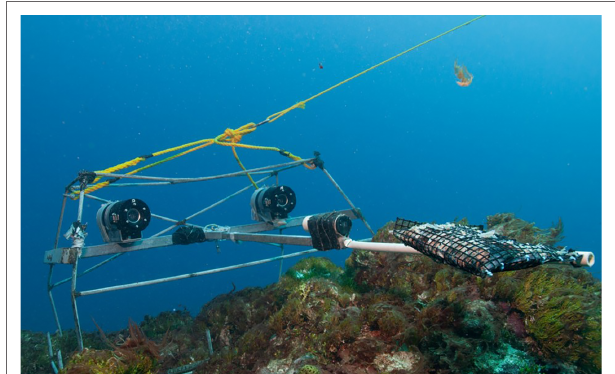
FIGURE 1 | Stereo BRUVS deployed in situ : a steel frame on which is mounted one or two video cameras (typically GoPro or small Sony camcorders) in underwater housings, in either a mono or stereo configuration. A container of bait is projected 1.5 m in front of the camera, attracting fish into the BRUVS video view. From Langlois et al.